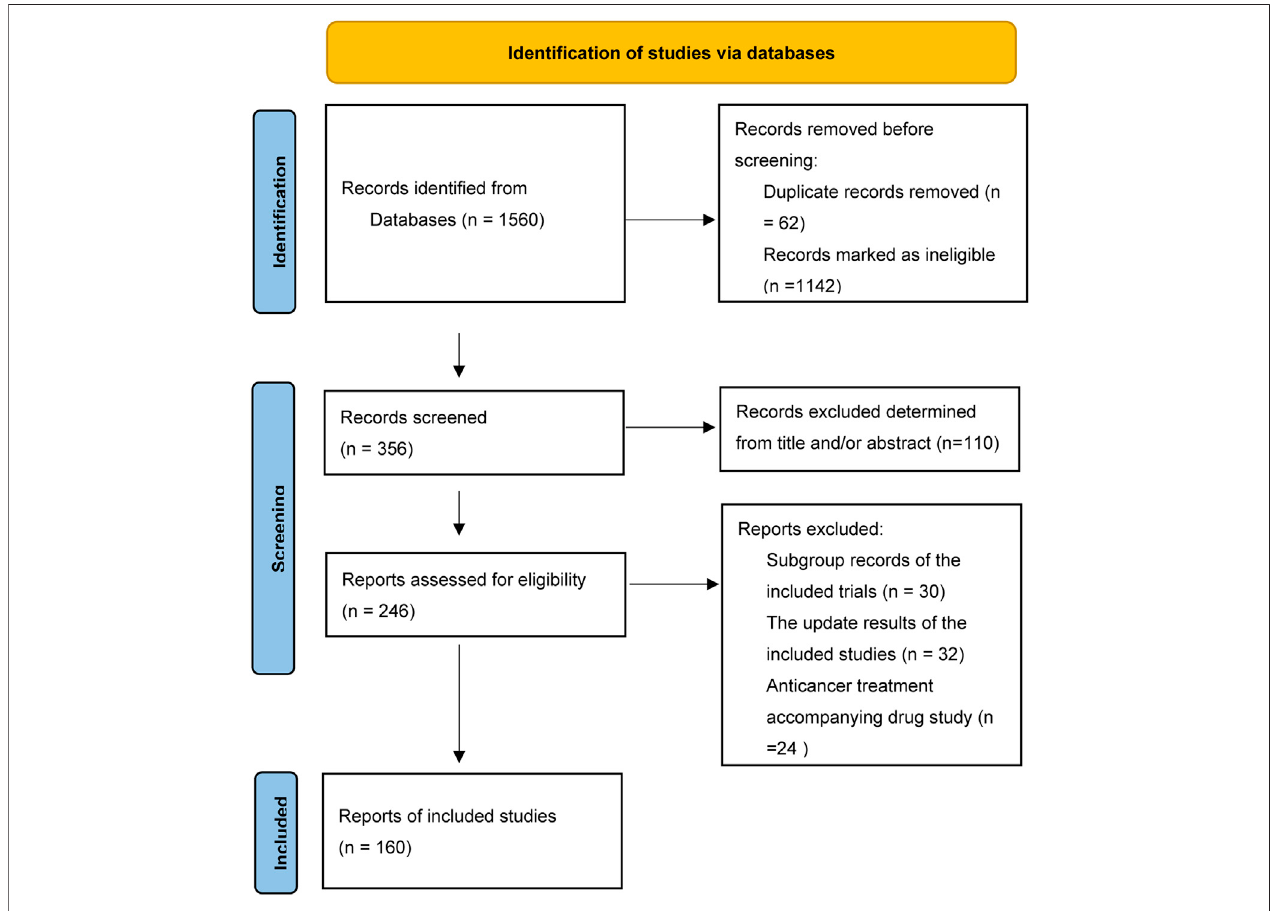
FIGURE 1 | The fl owchart of the studies included in this